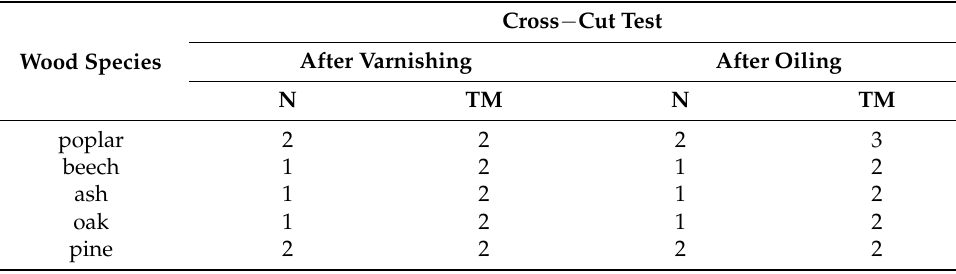
Figure 10. Typical images of cross − cut areas in poplar and oak wood after varnishing and oiling. Table 7. The test method results for assessing the resistance of coatings to separation from wood according to ISO 2409:2020 [46].